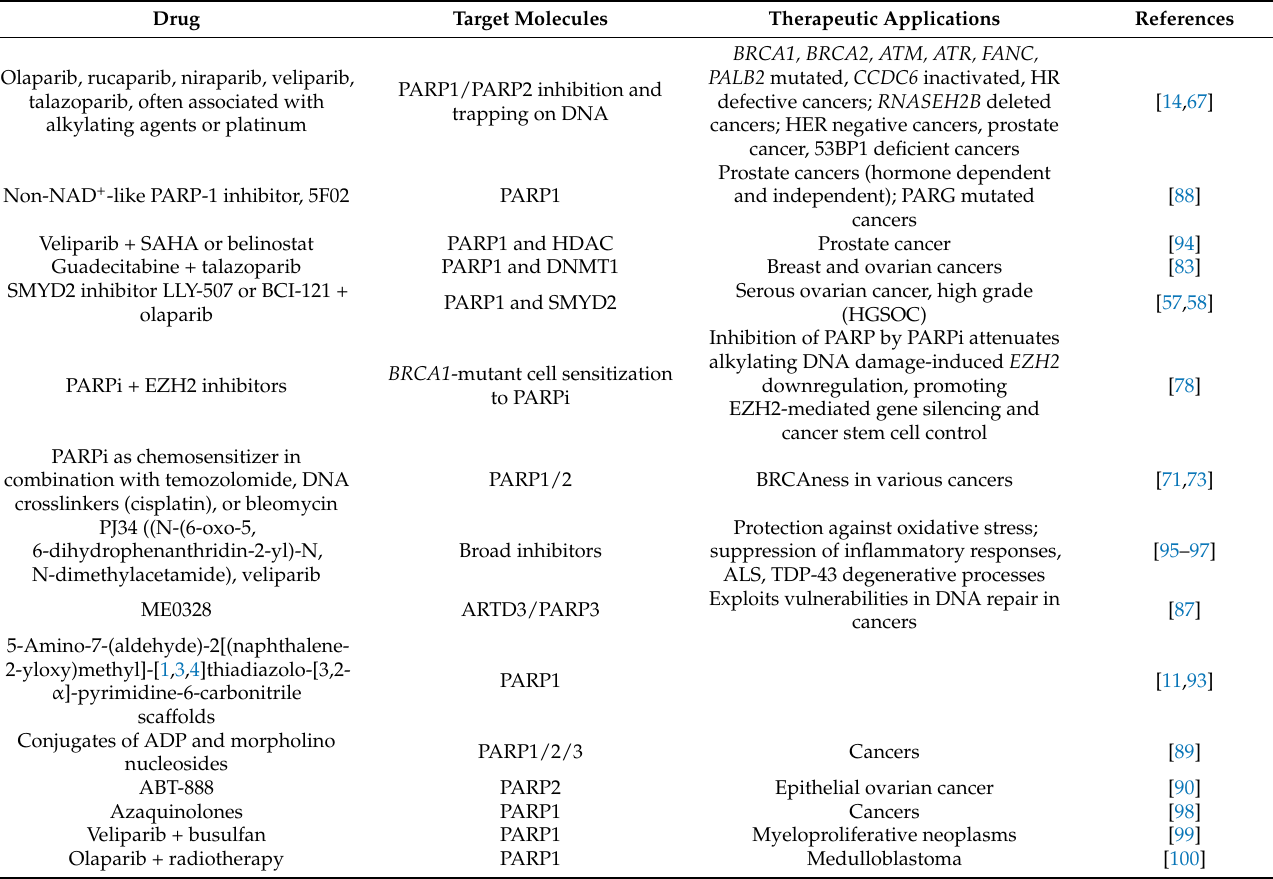
Table 1. Selective inhibitors of PARPs (PARP1/2/3) and therapeutic